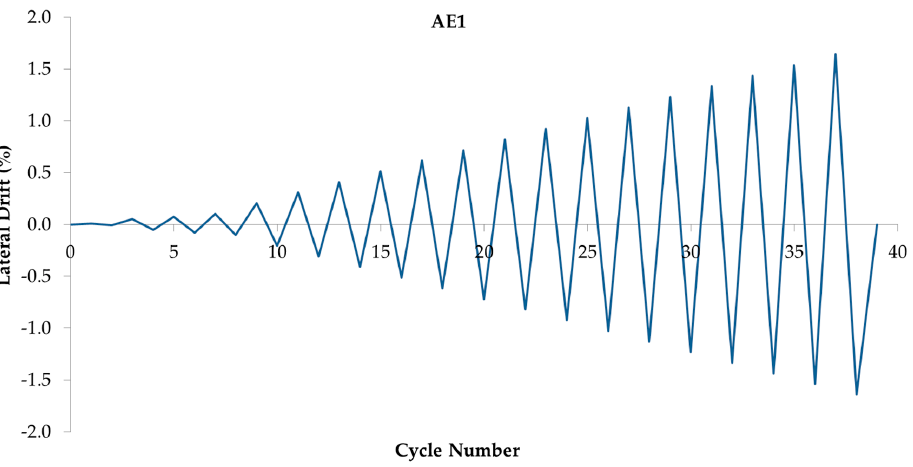
Figure 28. Cyclic loading protocol of specimen AE1.